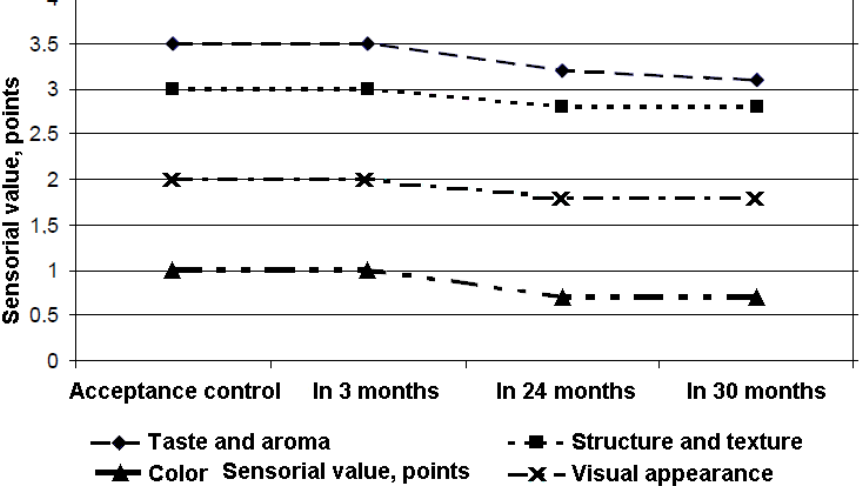
Figure 1. Results of sensorial evaluation of butter after long-term storage [14].